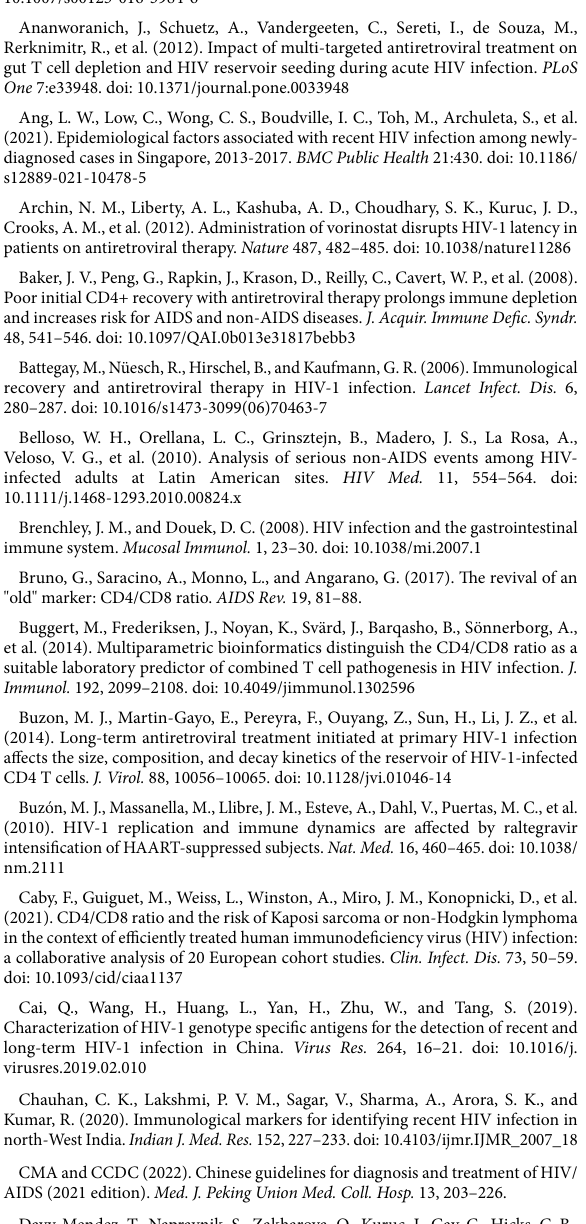
SUPPLEMENTARY FIGURE S5 The recovery speeds of CD4 + T-cell count (A) and CD4/CD8 ratio (B) among HIV-1 recent infection and long-term infection with or without AIDS groups during 12 months of cART. *, p < 0.05; **, p < 0.01; ***, p < 0.001; ns, p > 0.05. RI, recent infection; LI, long-term infection; mo, month.